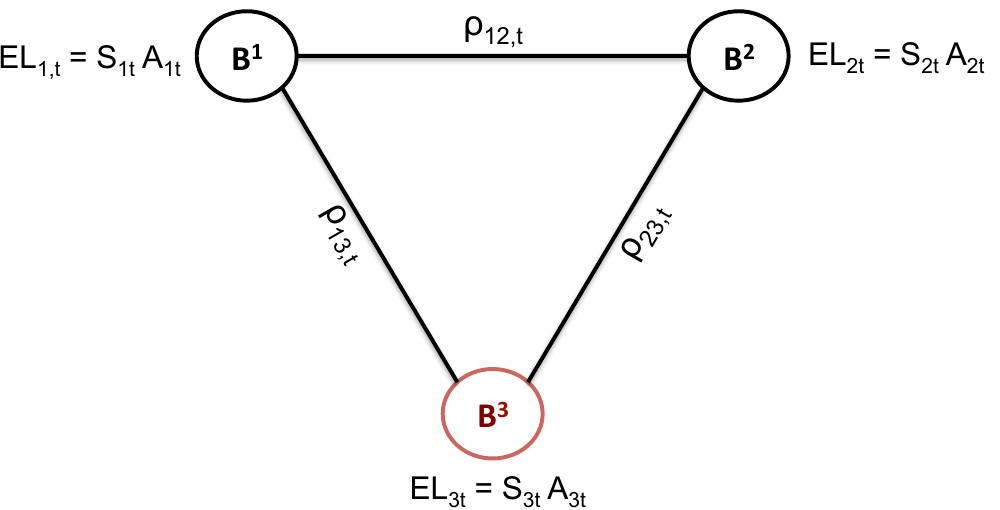
Figure 1. Correlation structure, stylized banking system. Notes: simulated correlation structure between two “safe” banks, B 1 and B 2 , and a “troubled” bank B 3 , at a certain time t . All banks are associated with their expected losses, and links between each are based on the partial correlation coefficients ρ mn